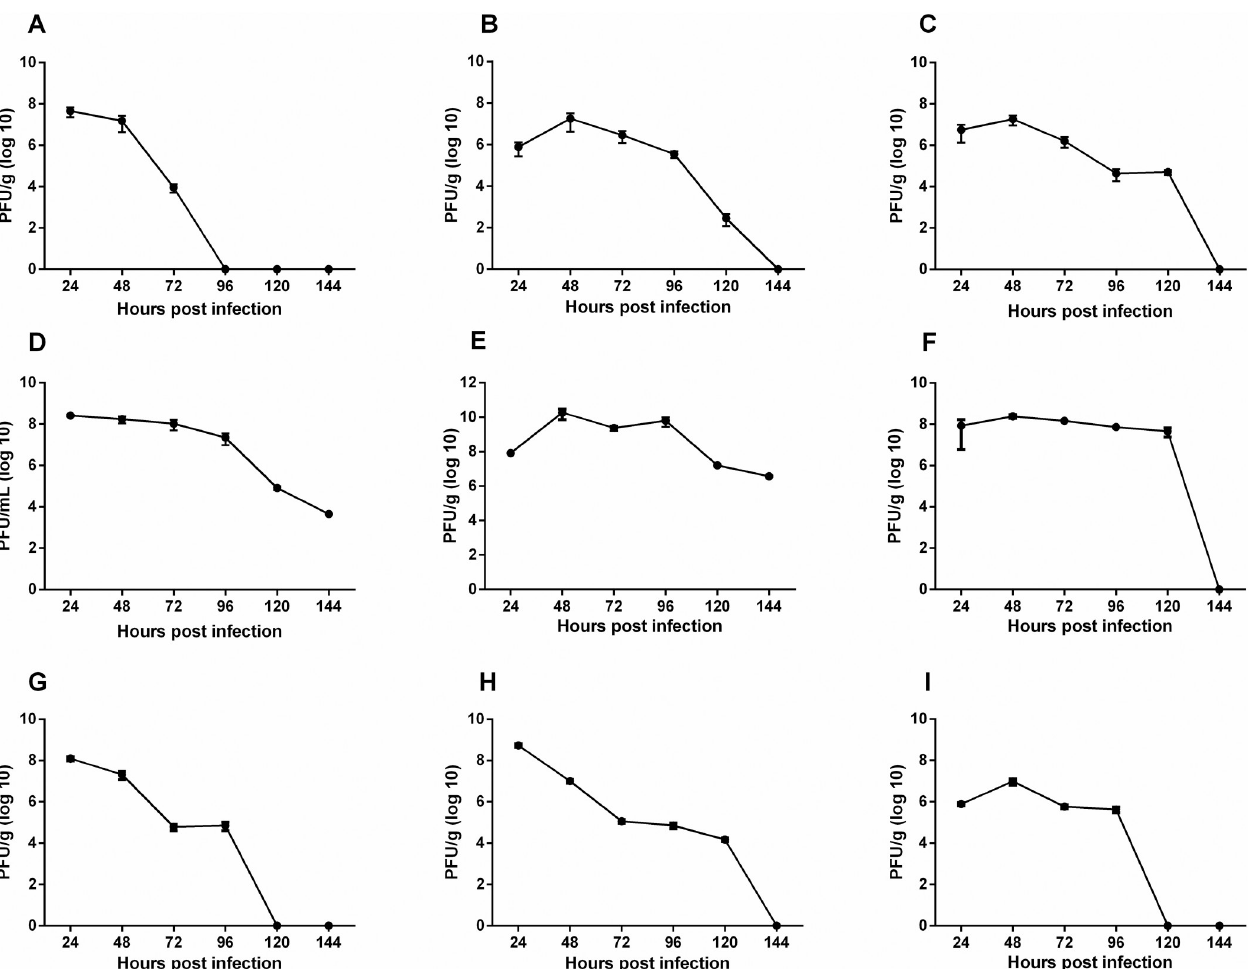
Fig 14. MAYV load on organ and tissues. 15-day old Balb/c mice infected in the rear footpad with 2.57 x 10 6 PFU. At 24, 48, 72, 96, 120 and 144 hpi, liver (A), spleen (B), heart (C), serum (D), right and left ankles E and F), right and left quadricep muscles (G and H) and eyes (I) were harvested and homogenized, and the amount of infectious virus present was quantified by plaque assay on Vero cells. N = 3